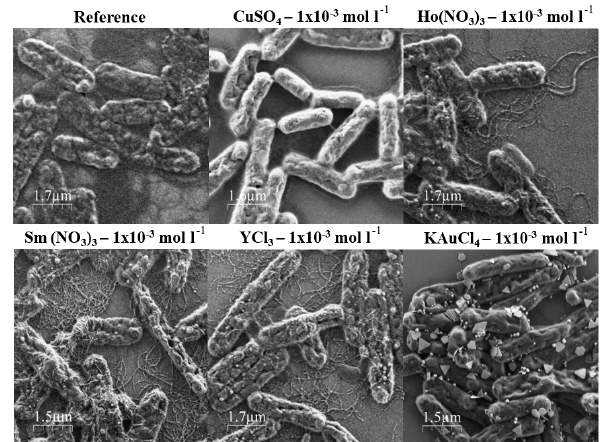
Figure 2. SEM images from L. sphaericus JG-B53 cells from the metal binding test after 2 days’ incubation with 1 × 10 − 3 molL − 1 CuSO 4 , Ho(NO 3 ) 3 , Sm(NO 3 ) 3 , YCl 3 and KAuCl 4